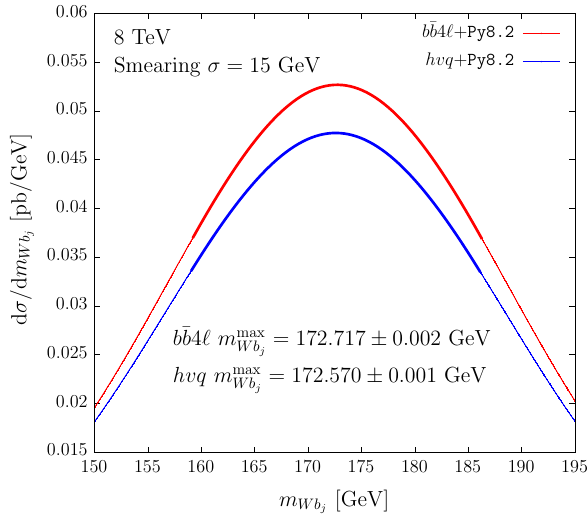
Fig. 11 Smeared d σ/ dm Wb distribution obtained with the b ¯ b 4 (cid:4) and j h v q generators interfaced with Pythia8.2 , for m t = 172 . 5